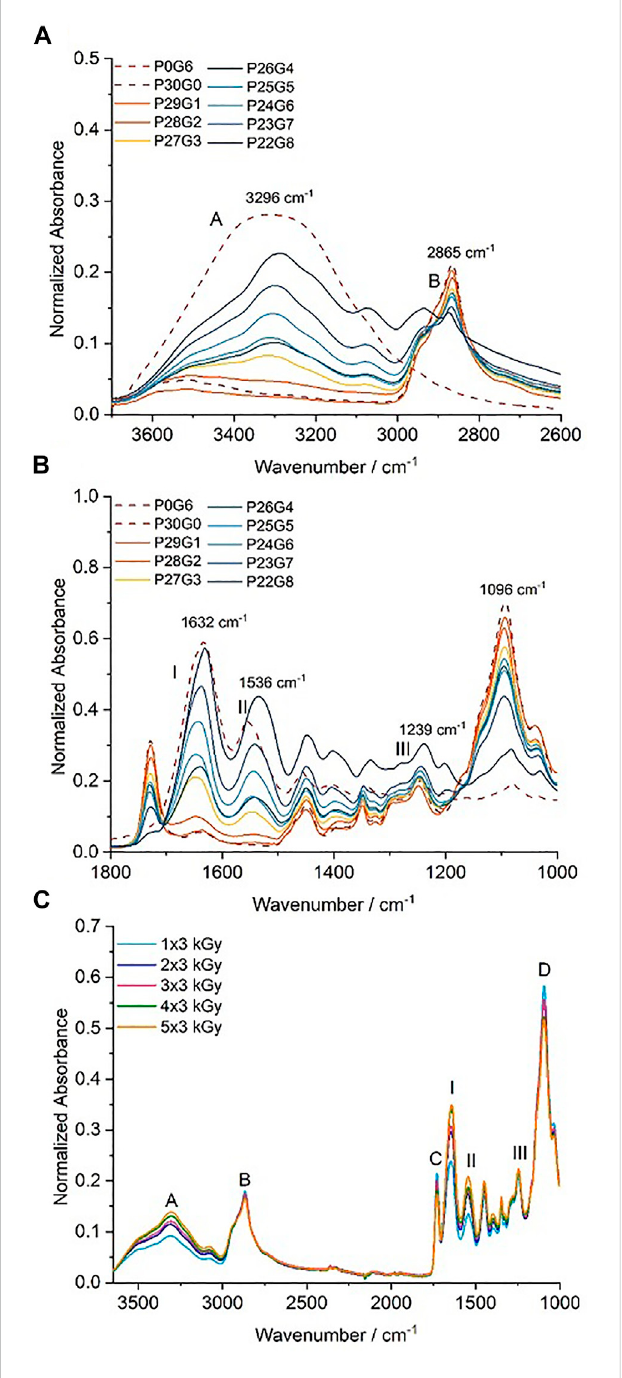
FIGURE 6 Attenuated total re fl ectance-infrared spectroscopy (ATR-FTIR) spectra ofhydrogelswith variation of (A) and (B) differentPEGDA/gelatin proportions irradiated with 6 kGy, and (C) the differential irradiation doses with fi xed PEGDA/gelatin concentration of